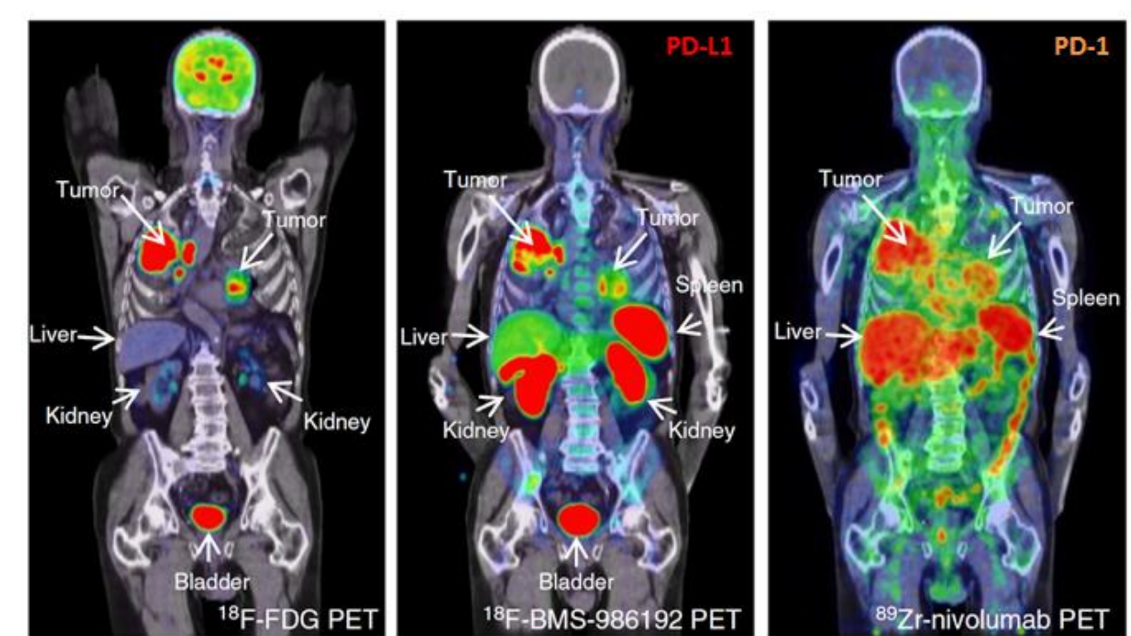
Figure 4. Comparison of [ 18 F]FDG PET/CT with anti-PD-L1 (18F-BMS-986192) and anti-PD-1 (89Zr-labeled Nivolumab) immuno-PET images in the same patient with NSCLC. Along the high glucose metabolism of the tumor in both lungs and mediastinal lymph nodes, a heterogeneous tracer uptake for 18F-BMS-986192 PET/CT and 89Zr-labeled Nivolumab PET/CT within and between tumors is demonstrated. Modified from Niemeijer AN et al. Whole body PD-1 and PD-L1 positron emission tomography in patients with non-small-cell lung cancer. Nat Commun 2018;9:4664. [106]; Licensed